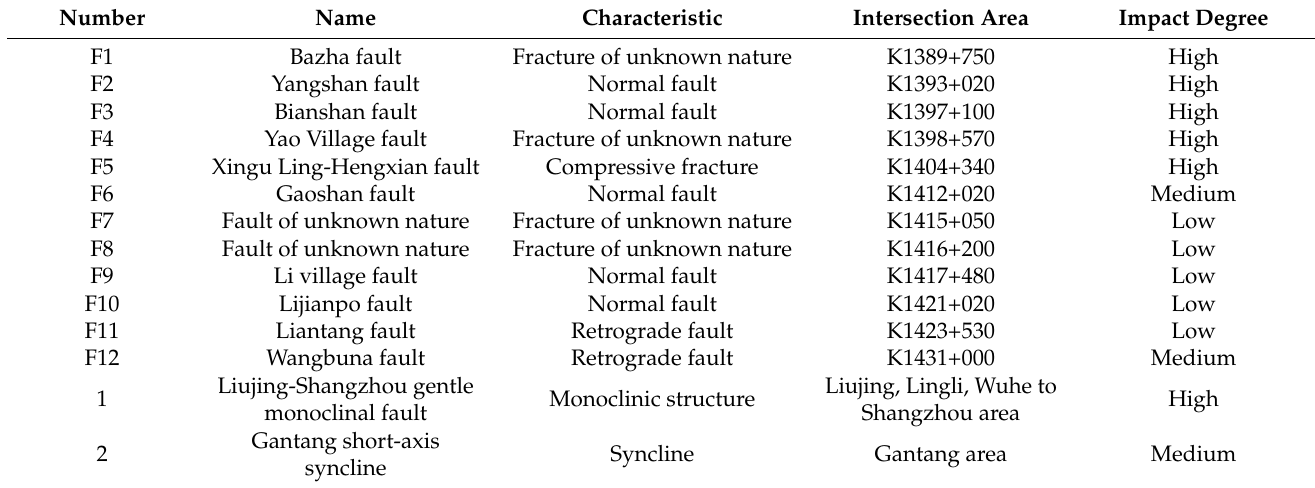
Table 1. List of main structures in the research